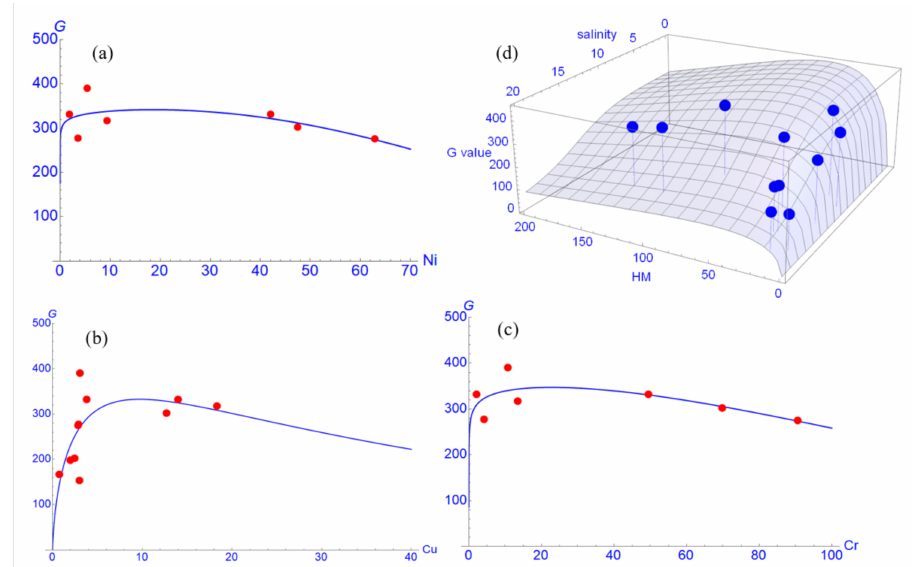
Figure 5. Tree growth rate ( G ) is dependent on concentration (mg / kg) of the contaminants Ni ( a ), Cu ( b ), and Cr ( c ). This is a fit to the multiplier function for metal contaminants (Equation (8)). ( d ) Response surface of G in dependence on the total root concentration of Ni, Cu, and Cr and on the soil salinity. For Cu, MacFarlane and Burchett [75] reported that Avicennia marina was found to be highly tolerant to Cu. It was accumulated in root tissue but at concentrations of 200 µ g / g and higher, no further increases in root Cu levels occurred. Significant reductions in seedling height, leaf number and area were found with significant increases in Cu concentrations at 100 µ g / g sediment Cu. At Cu